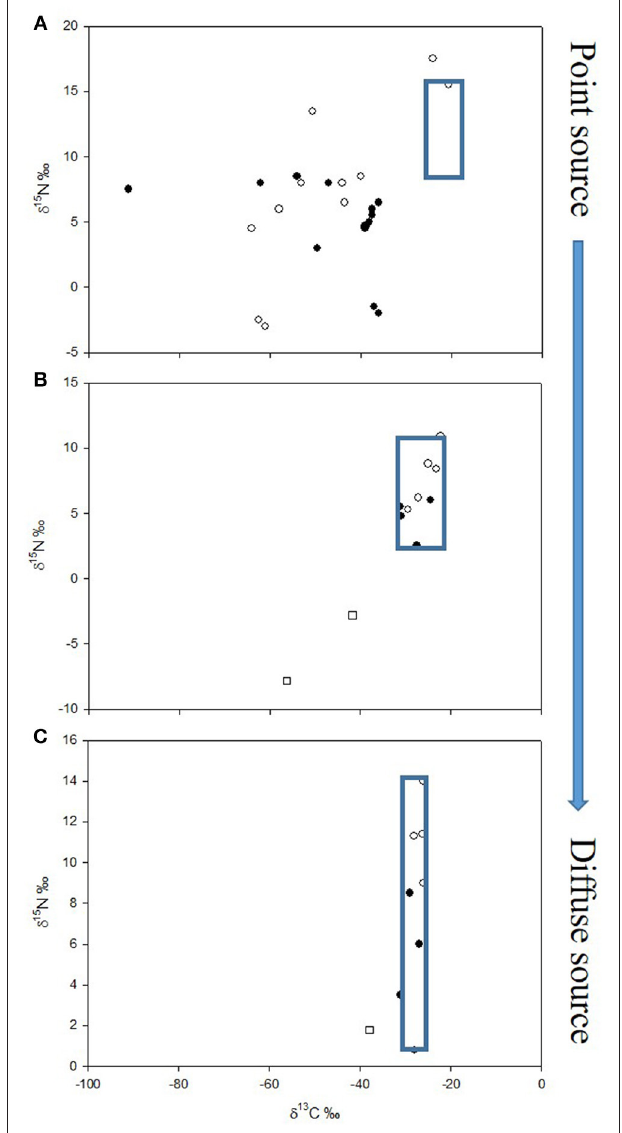
FIGURE 2 | Stable isotope bi-plots of food webs across a spectrum of point to diffuse sources of methane with corresponding decrease in strength of δ 13 C value as a tracer of methane-derived carbon (MDC); blue boxes indicate components of the food web with small / negligible influence of MDC. (A) Gulf of Alaska (redrawn with permission from Levin and Michener, 2002): solid symbols—pogonophoran field infauna; open symbols—clam field infauna. (B) Plußsee (strongly stratifying small lake, data from Harrod and Grey, 2006): open circles—fish; solid circles—macroinvertebrates; open squares—chironomid larvae. (C) Loch Ness (weakly stratifying large lake, data from Jones and Grey, 2011): open circles—fish; solid circles—invertebrate and basal resources; open squares—chironomid larvae.